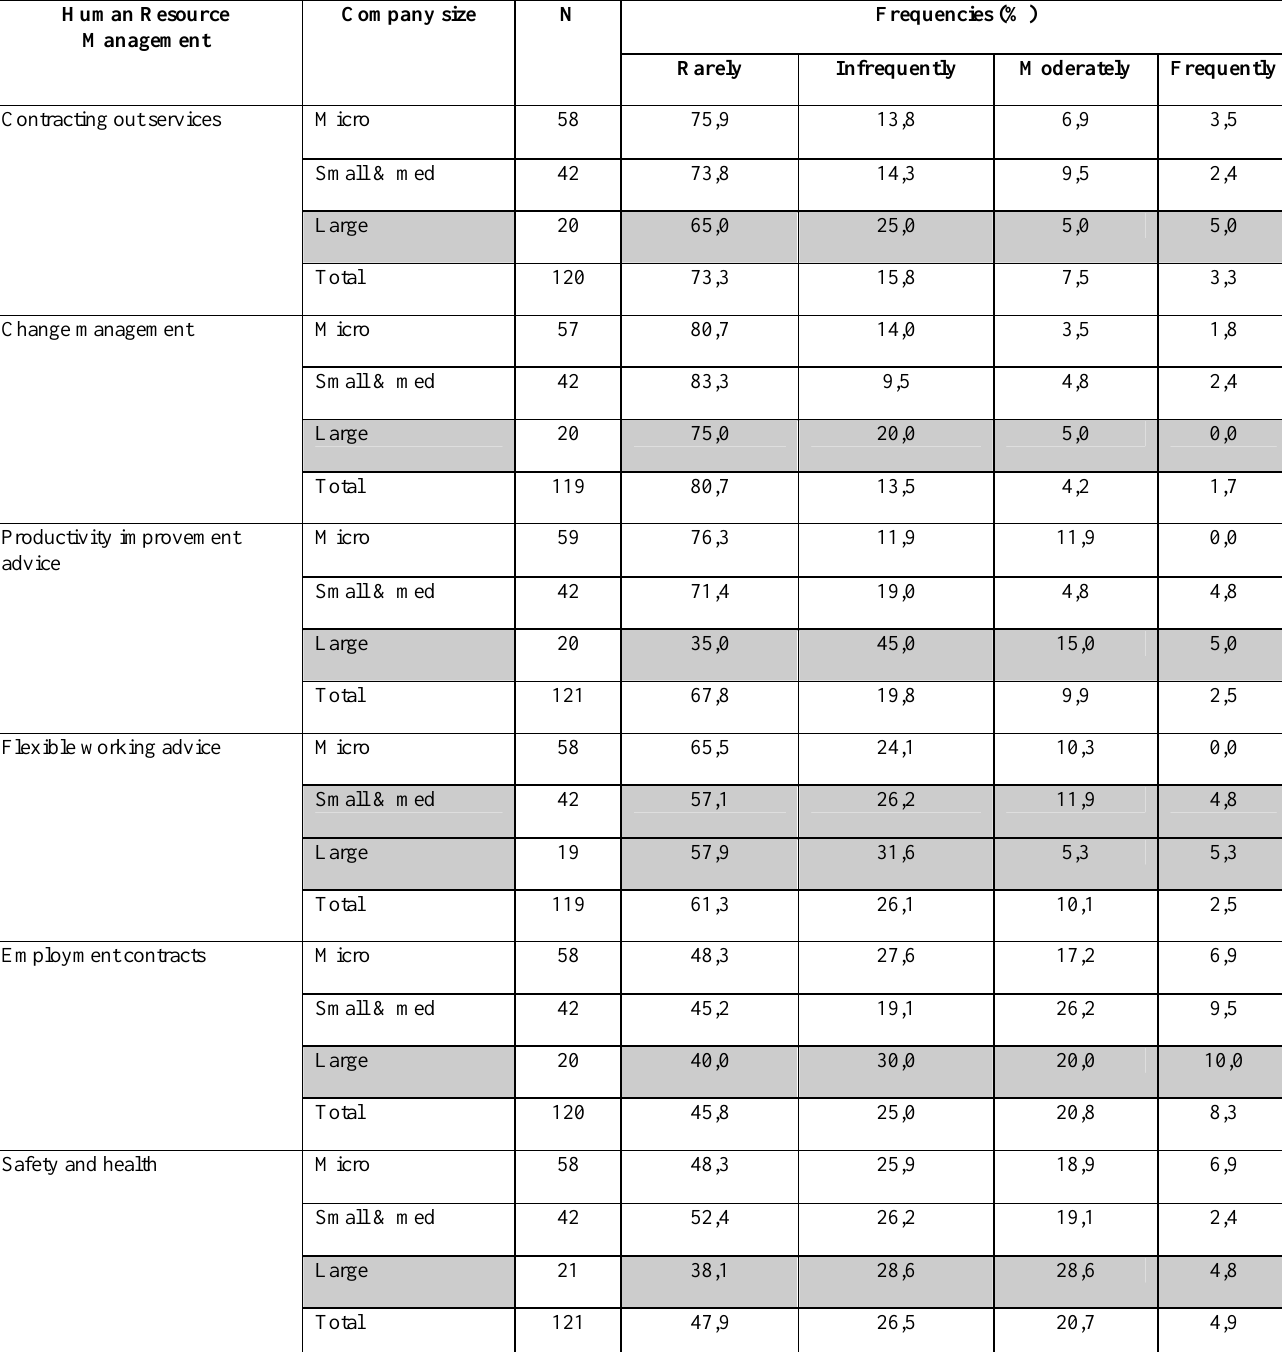
Table 5: Comparison between company size and responses to human resource management Human